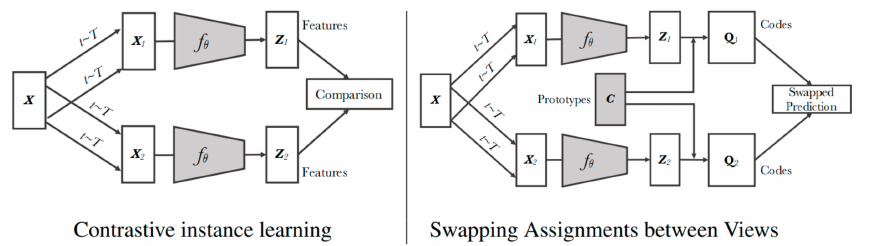
Figure 14. Conventional contrastive instance learning vs. contrastive clustering of feature representa- tions in SwAV [13].